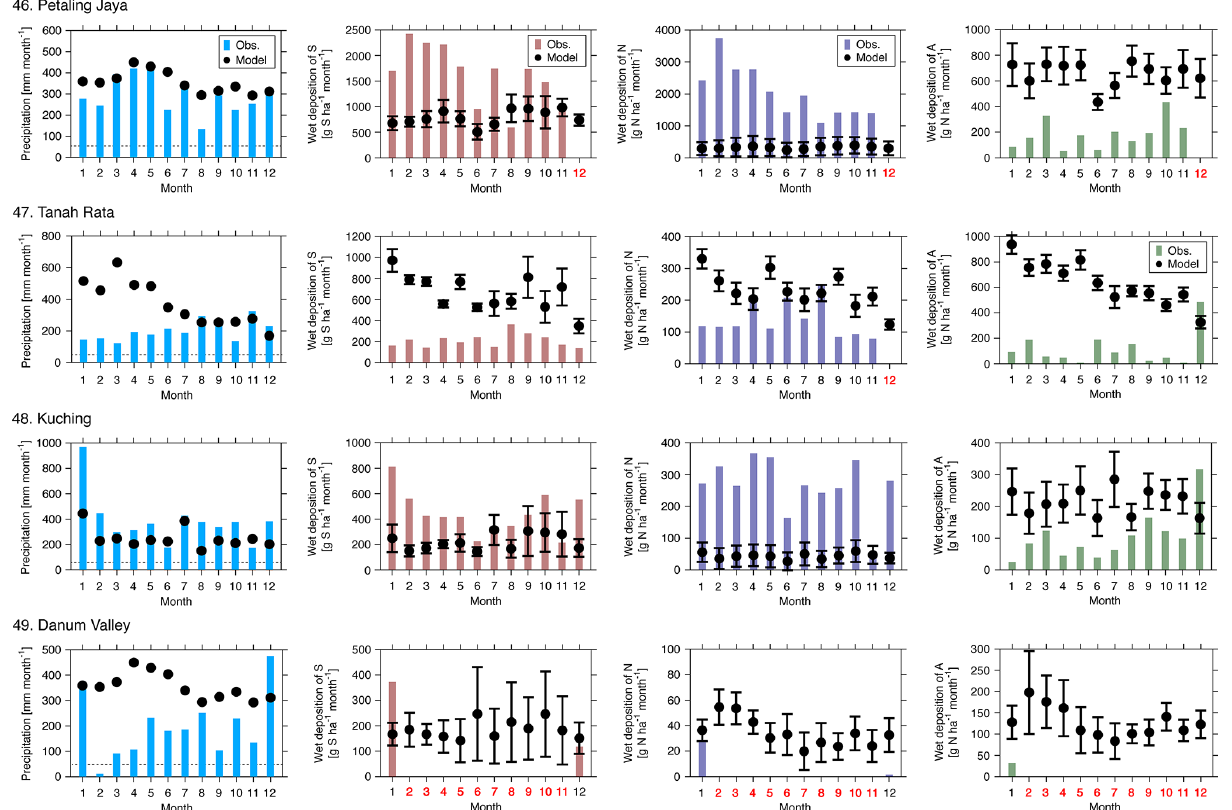
Figure 7. Monthly accumulated precipitation and wet depositions of S, N, and A over Malaysia. Whiskers represent the standard deviation among the seven models. Months shown in red indicate a lack of observational data. Table 8. Statistical analysis of model performance for four sites in